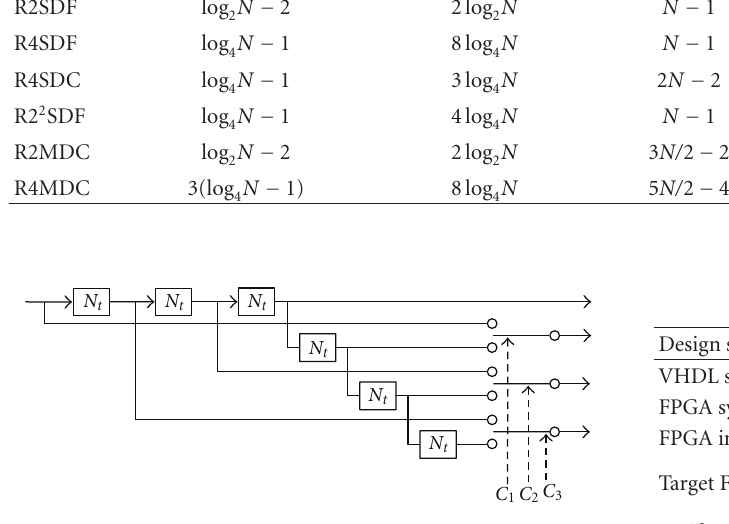
Figure 1: R4SDC commutator of stage t .